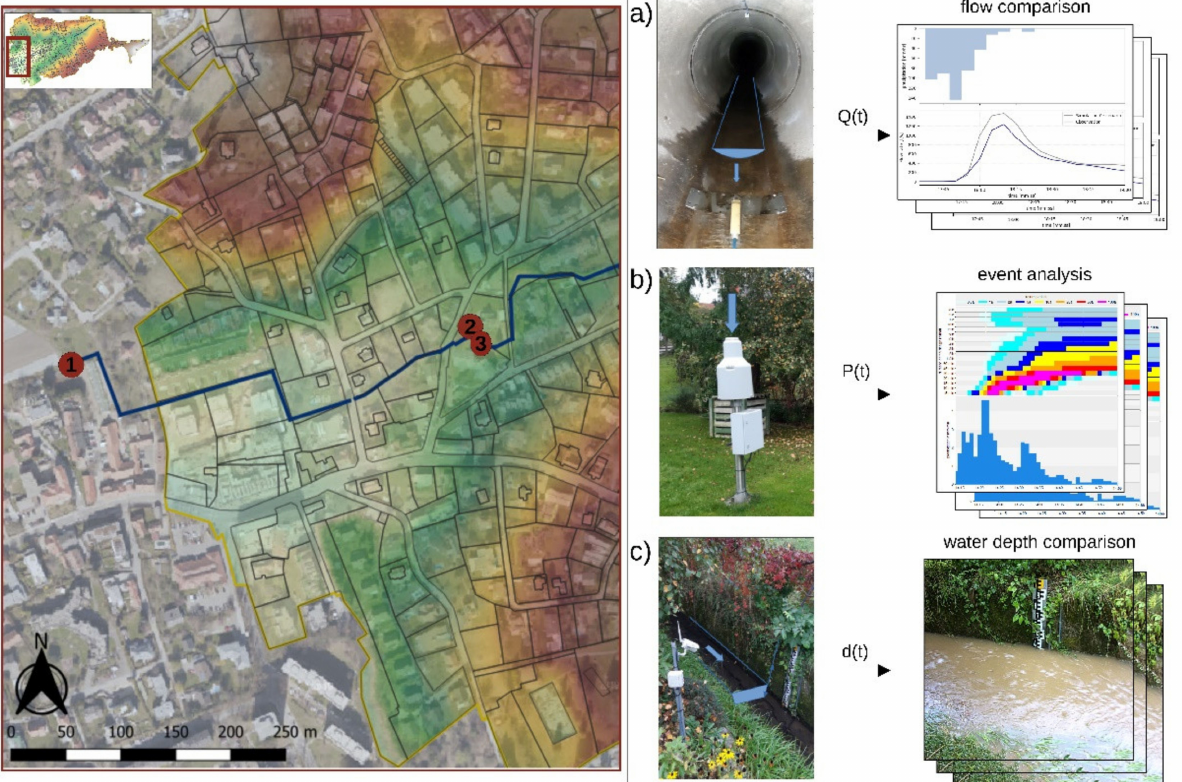
Figure 4. Locations of the measurement systems in the Annabach Catchment: ( a ): flow mea- surement system, ( b ): rain gauge, ( c ): camera system to generate frames of water depth in the Annabach